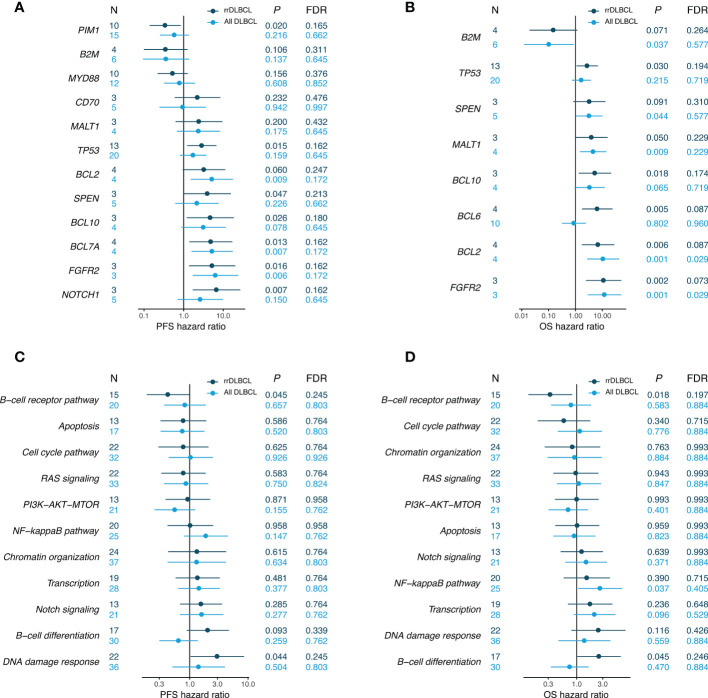
Associations between survival probability and mutations in pretreatment tumor samples. Hazards ratios (HRs) are shown separately for pretreatment samples of rrDLBCL and all DLBCL including cured disease. HR and P values were corrected by the COO and IPI score. (A, B) Genes with P values < 0.05 in the univariate analysis for rrDLCL are included. (C, D) Pathways with > 9 mutated rrDLBCL samples are included.